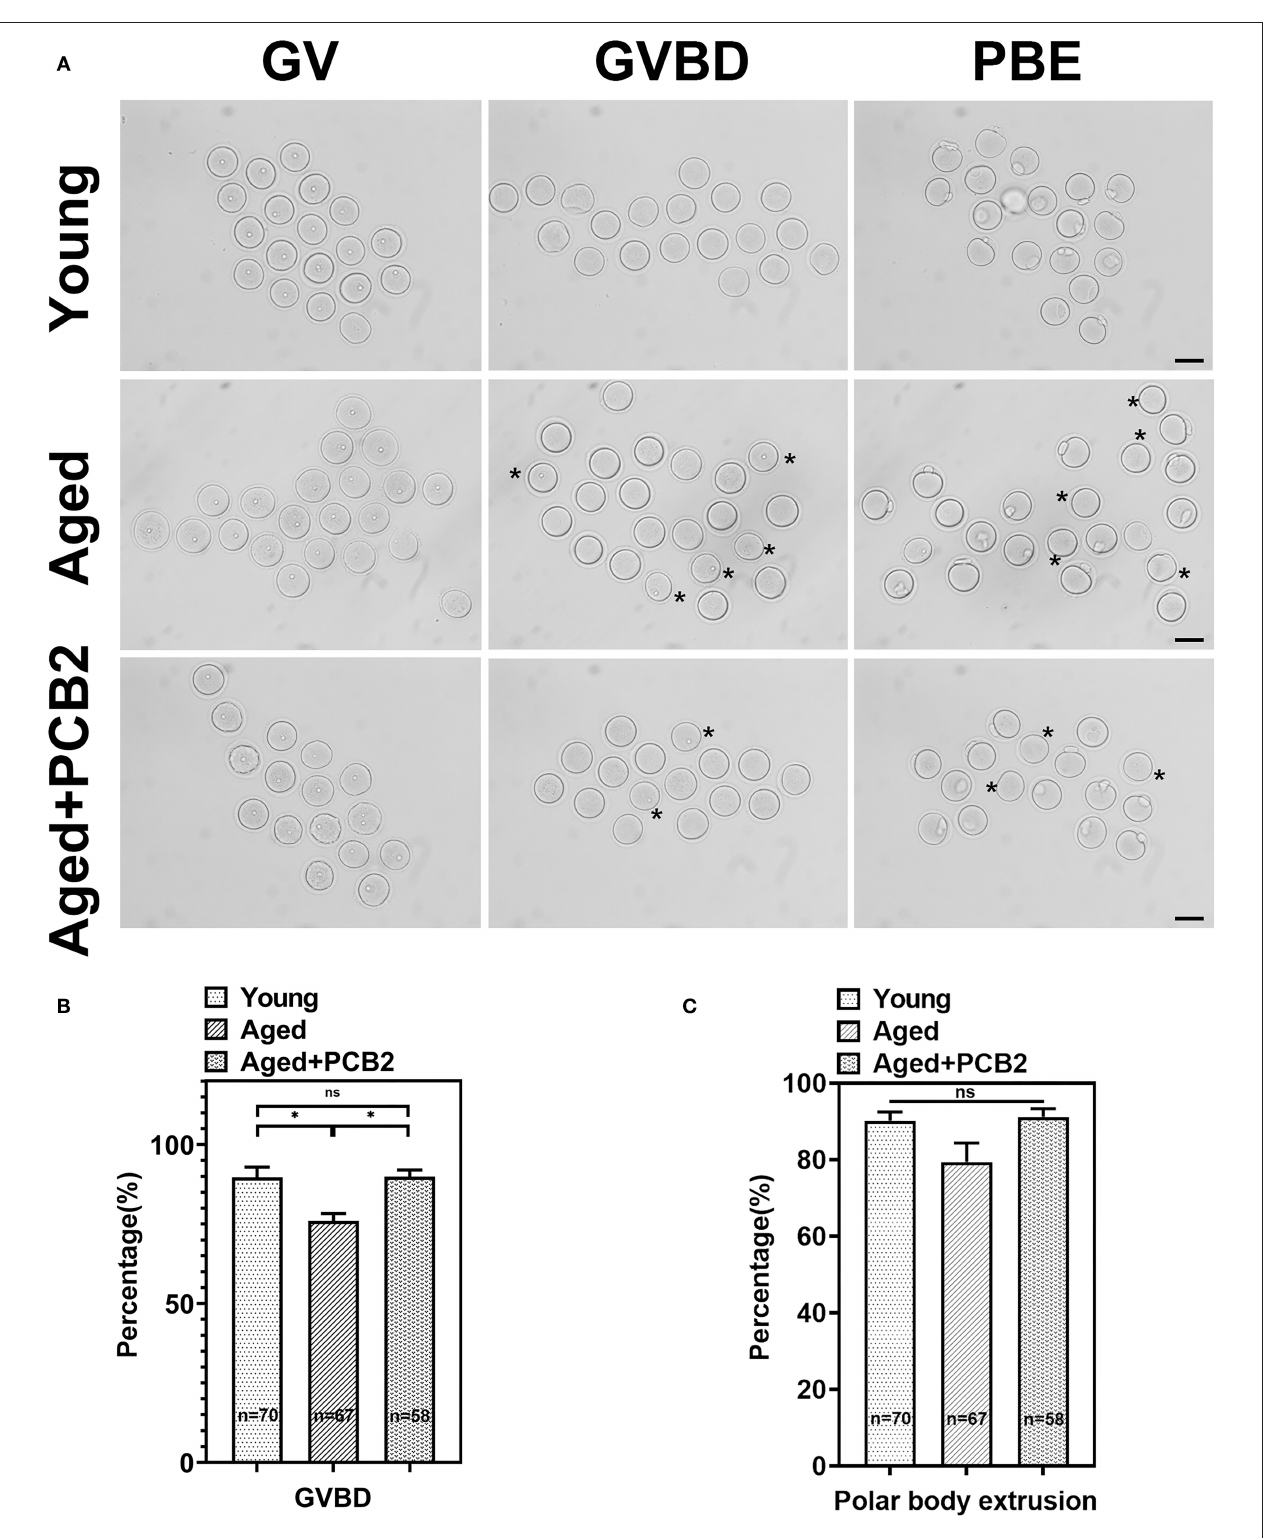
FIGURE 1 | PCB2 supplementation can improve germinal vesicle breakdown (GVBD) rate of aged oocytes. (A) Oocytes were cultured in vitro with or without PCB2 supplementation to analyze GVBD and polar body extrusion (PBE) rates. Scale bar, 50 µ m. (B,C) The GVBD and PBE rates of oocytes were recorded in different groups. Data are presented as mean percentage (mean ± SEM) of at least three independent experiments. * P < 0.05.